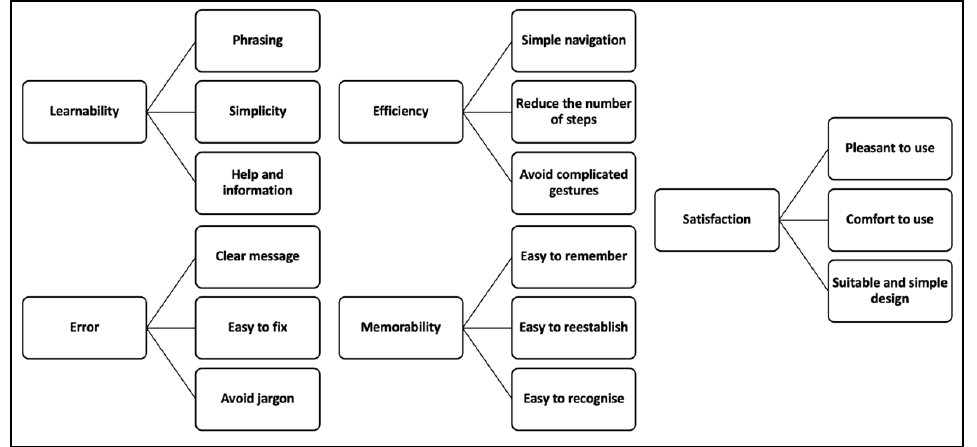
Figure 2. Niel sen’s usability attributes mapping . Figure 2. Nielsen’s usability attributes mapping. Table 4. The user requirements